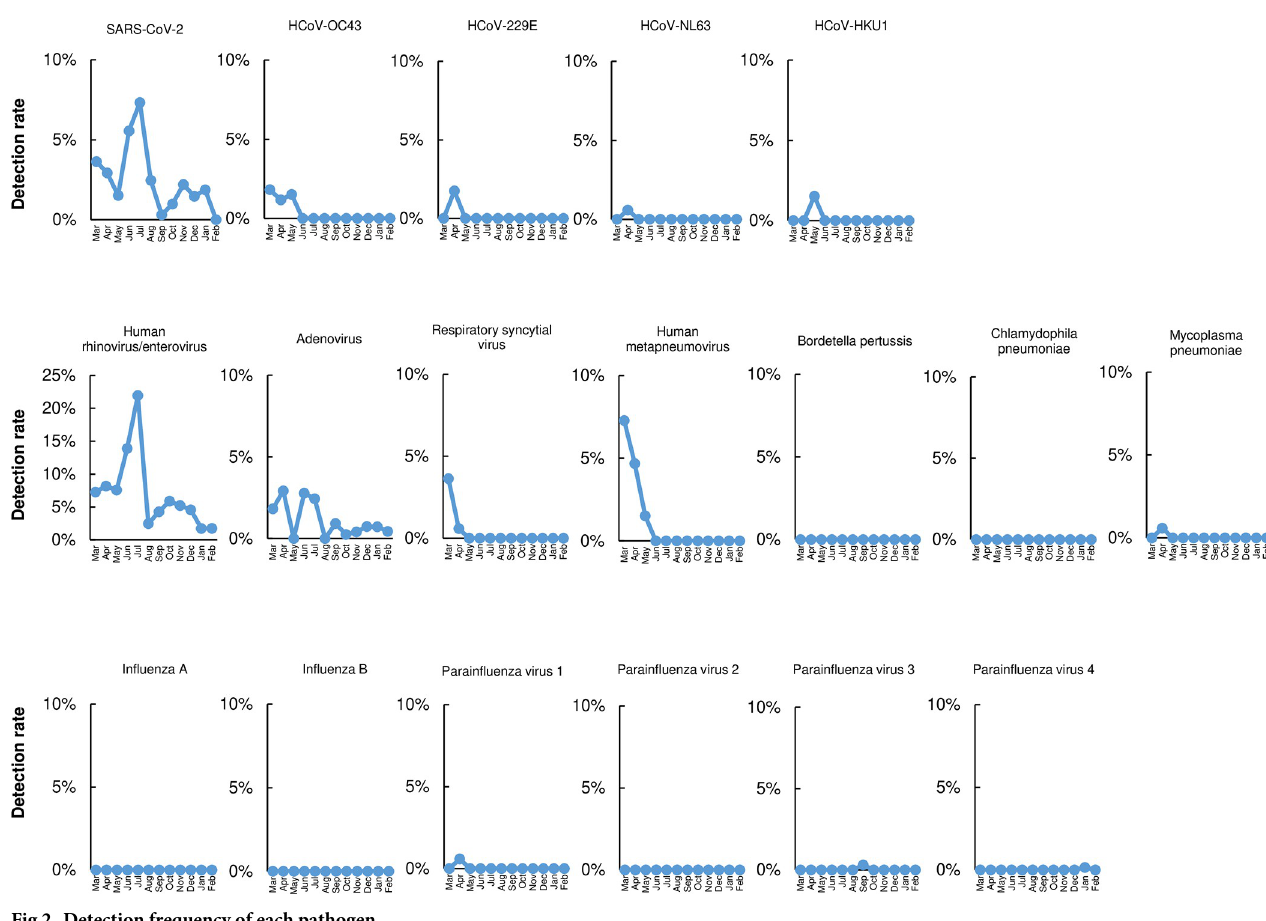
Fig 2. Detection frequency of each